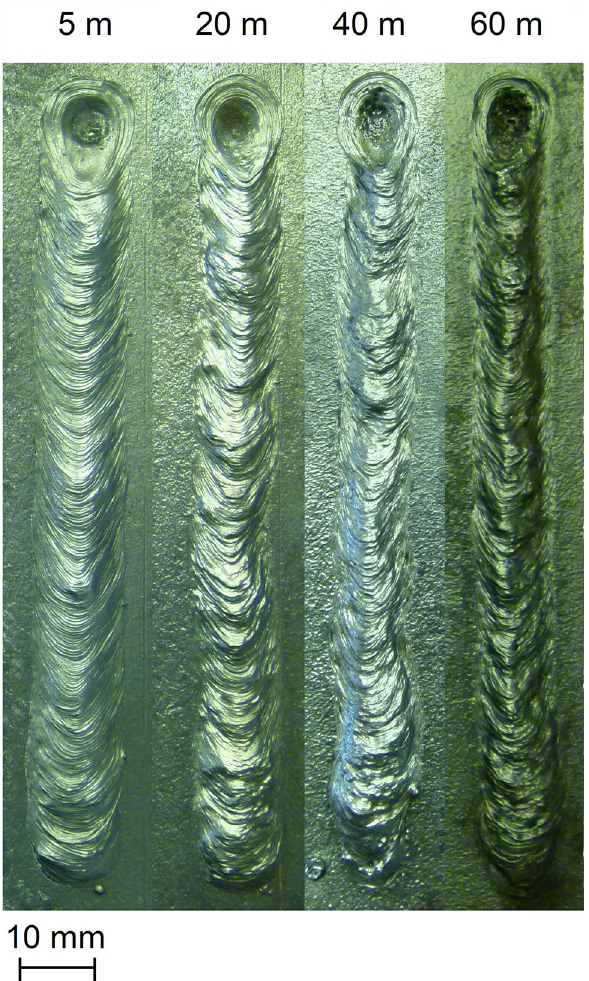
Fig. 13 Bead on plate weld seams welded with the stick electrode HK25 in the water depth 5 m, 20 m, 40 m, and 60 m. The param- eters used are listed in Table 2 (lower value of each